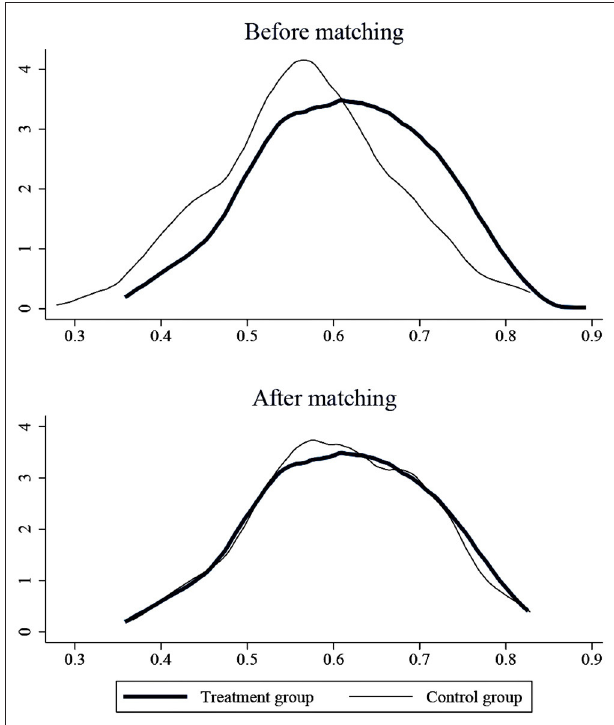
FIGURE 5 | Propensity score distributions for treatment and control groups.